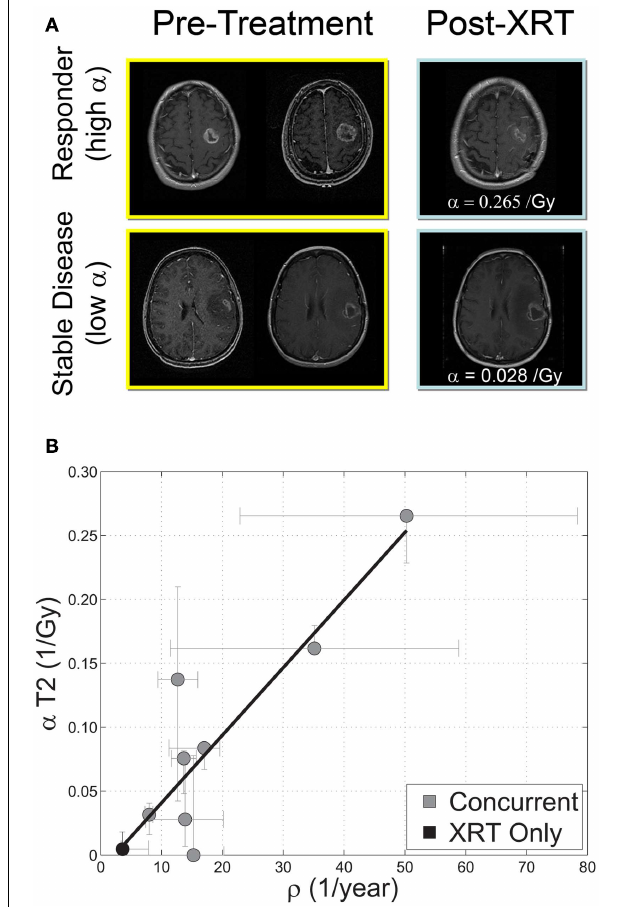
FIGURE 9 | (A) “Response to therapy is conventionally assessed by determining changes in gross tumor volume (GTV) on MRI prior to and after the administration of therapy. Post-contrastT1-weighted MRI images are shown for two glioblastoma patients that would typically be separated into generic groups: responder and stable disease.The radiation response parameter α gives an additional quantification of radiation response for each patient.” (B) “Relationship between radiation response and tumor proliferation rate parameters α (Gy − 1 ) and ρ (1/year), respectively, with α calculated relative to changes inT2 GTV post therapy r = 0.89, ρ (cid:28) 0.05, N = 9. Error bars on ρ are calculated by propagation of error in pre-treatment GTV as assessed by inter-observer variability of ± 1mm in equivalent spherical radius. Error bars in α are computed by taking the maximum and minimum values of α in a leave one out cross validation (LOOCV) technique.” Courtesy: Rockne et al. (2010), with permission